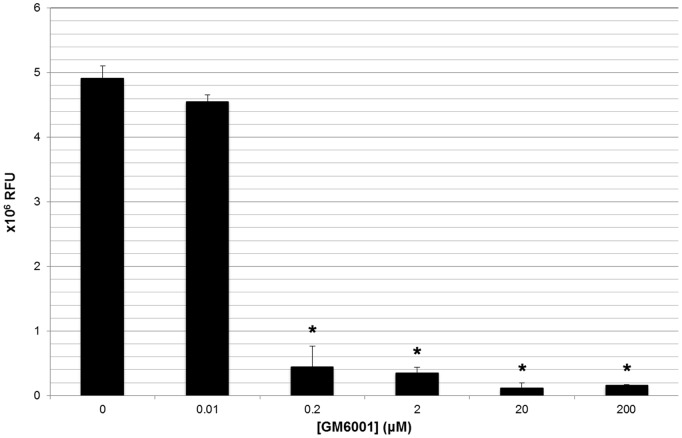

In vitro inhibition of MMP-9 by GM6001.Calibrated MMP-9 activity (Log 106), as measured by a fluorescent electrophoretic technique, was dramatically attenuated by GM6001 in vitro at various concentrations. Plasma concentrations of GM6001, measured 96 hours following a single 100 mg/kg subcutaenous dose (range 0.16−.26 µM or 60–100 ng/mL), approximated those needed in vitro to robustly inhibit MMP-9 (0.2 µM or 77 ng/mL). Groups marked with an asterisk (*) had significantly (P<0.05) different calibrated MMP-9 activity from reference (no GM6001) using a one tailed Student’s t-test.